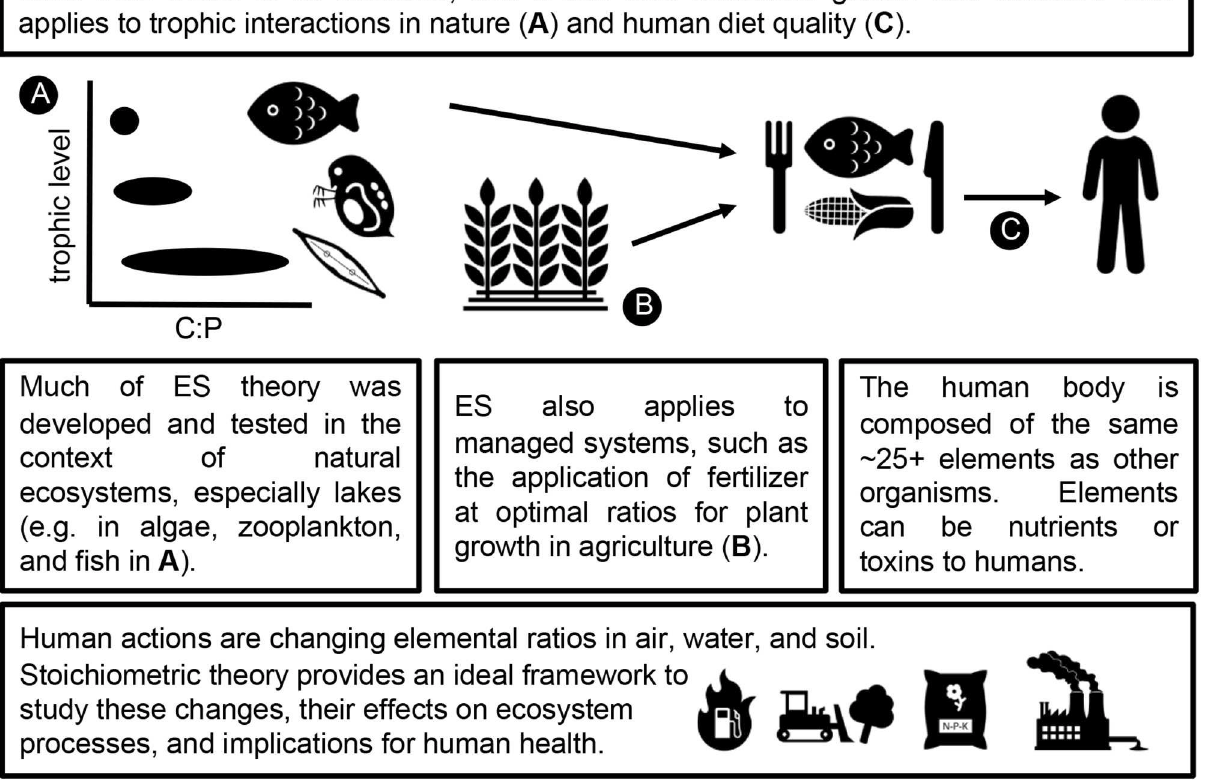
FIGURE 2 | A primer of ecological stoichiometry and an overview of its application to human health.